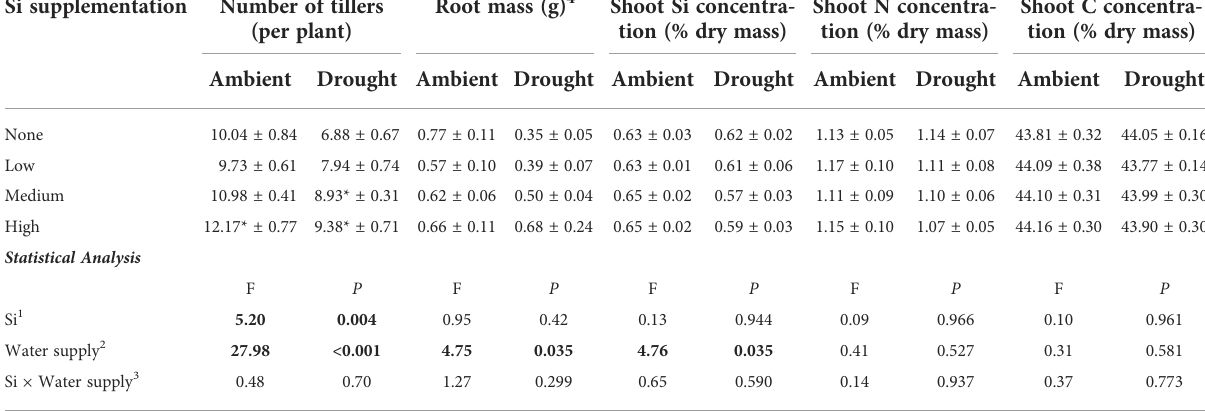
TABLE 2 Responses of plants grown with Si supplementation (low, medium and high; 39, 78 and 117 kg ha -1 ) compared to plants without Si supplementation (none) under ambient and drought conditions. Si